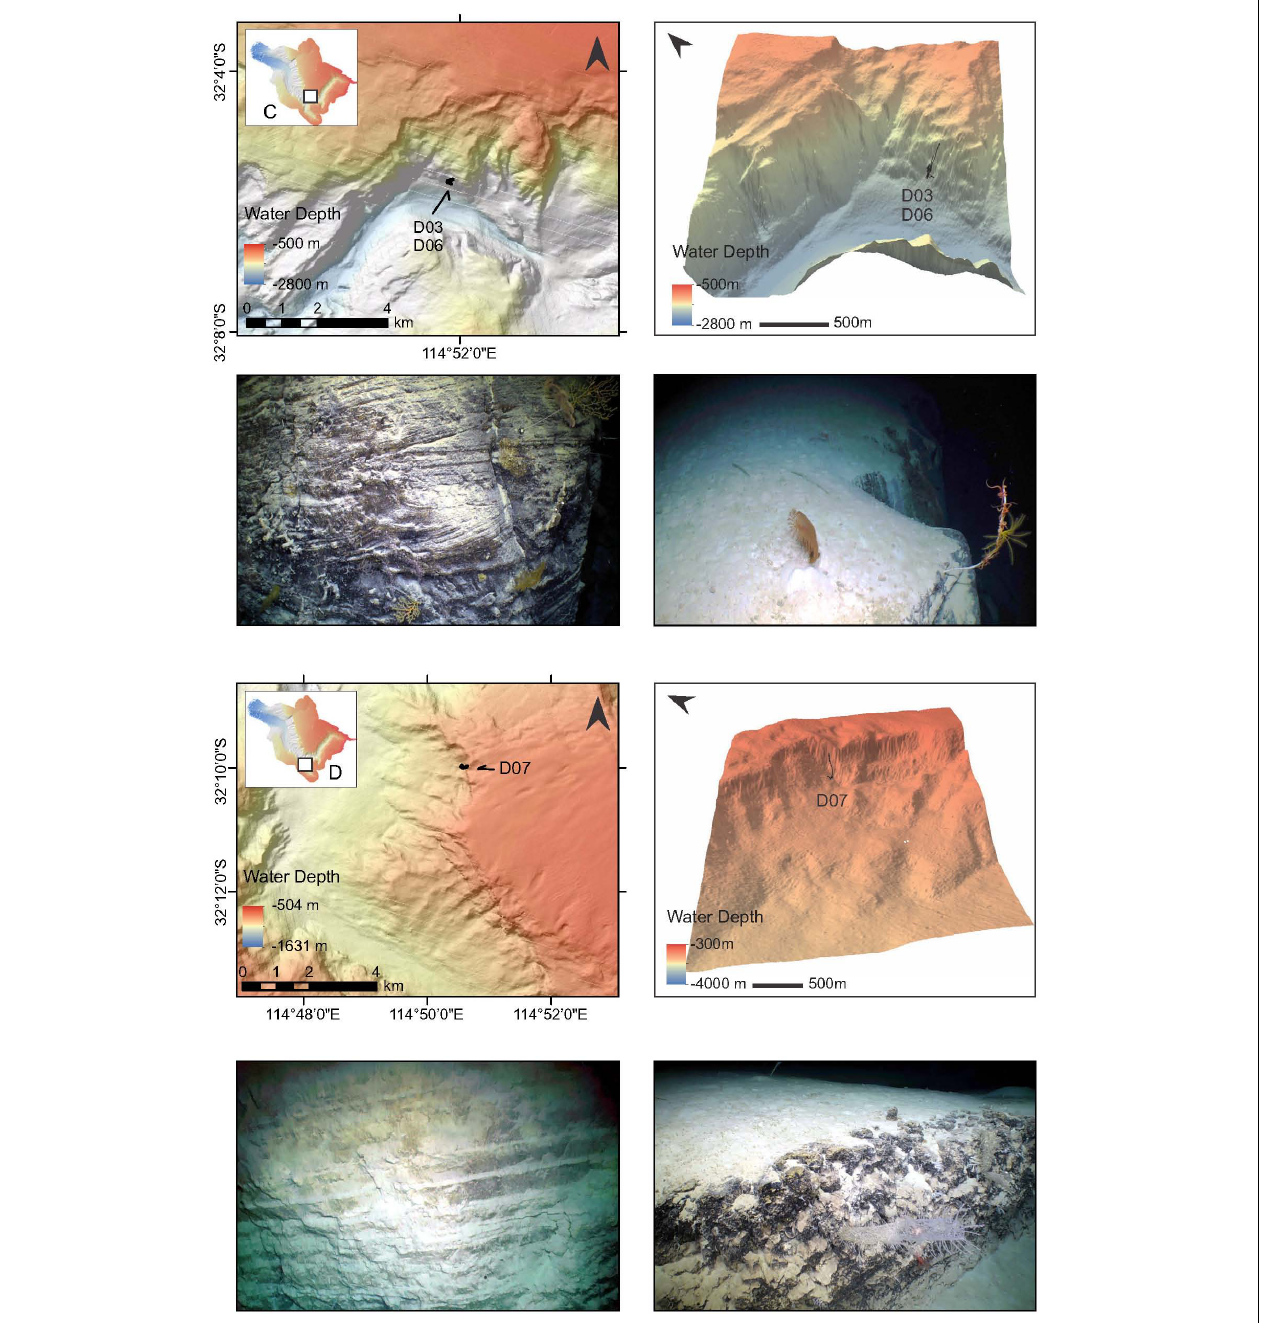
FIGURE 3 | High-resolution bathymetry maps and photos of lithologies of the canyon walls and substrates at ROV dive Sites C and D (note insets), located in the southern region of the canyon system. Black lines on the bathymetry maps depict ROV tracks, with each dive number indicated.